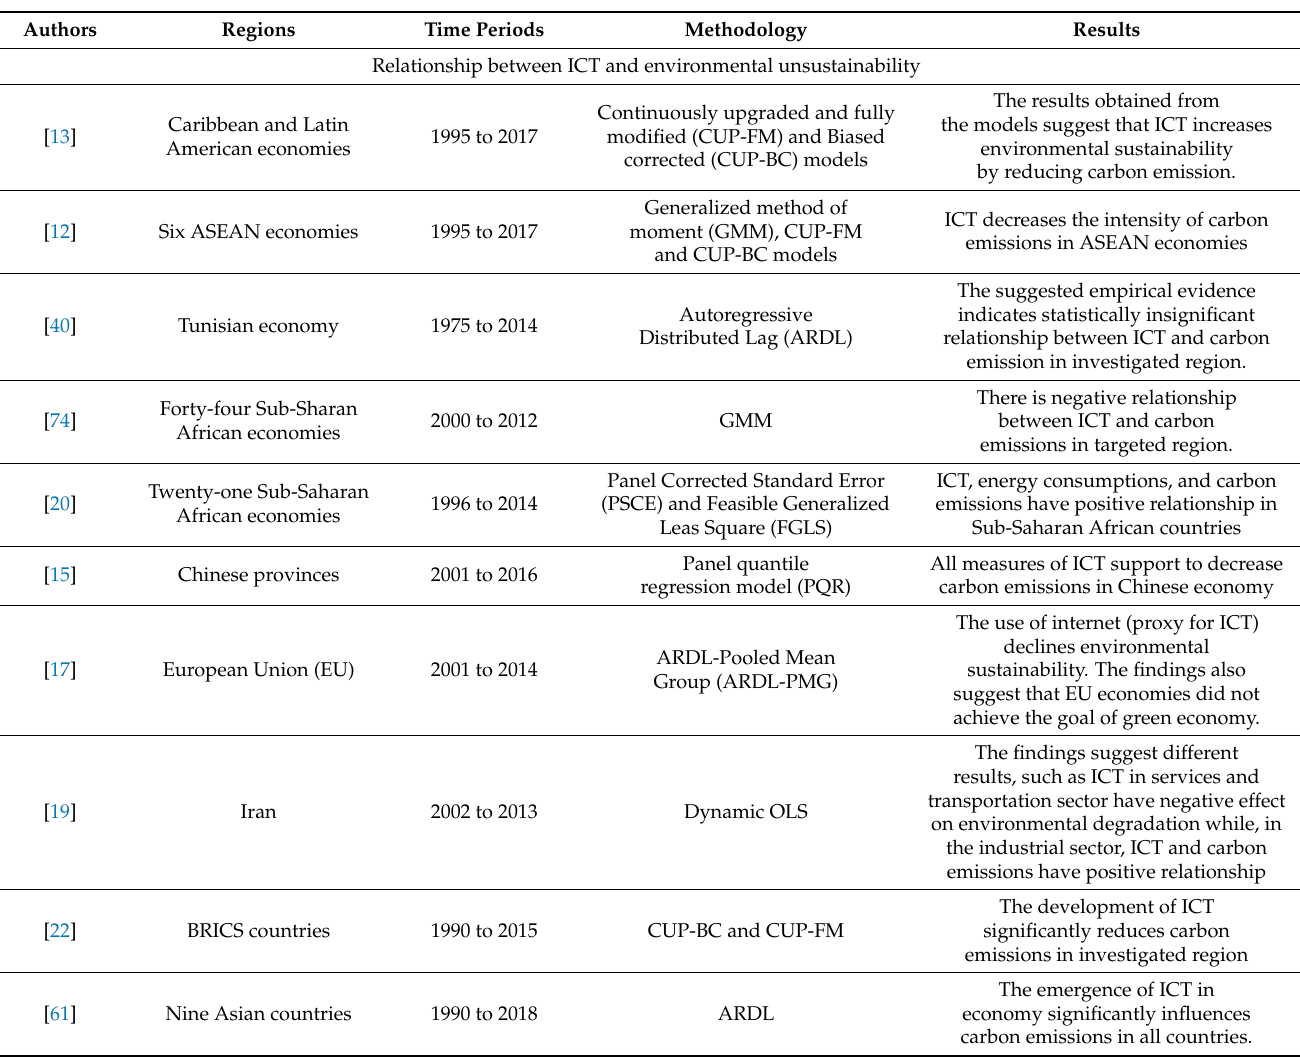
Table A1. Literature review’s summary in tabulated